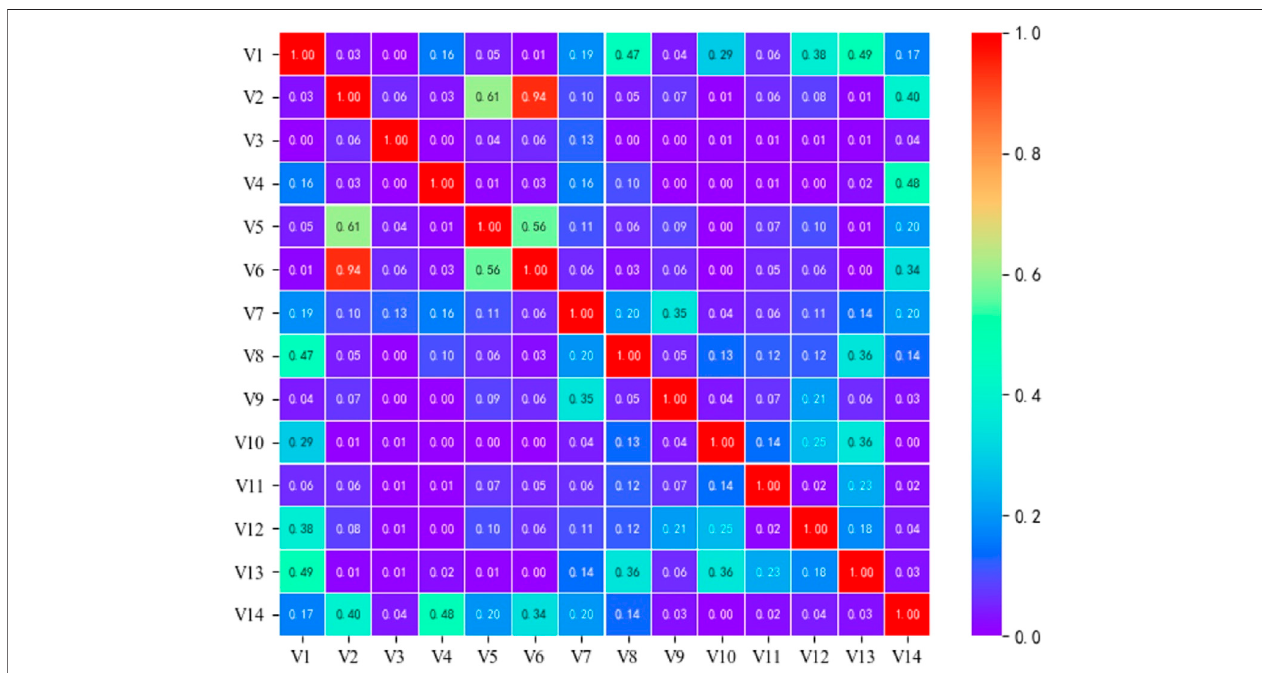
FIGURE 5 | Pearson correlation coef fi cient results. V1 Altitude; V2 Slope; V3 Aspect; V4 Curvature; V5 Topographic relief; V6 Surface roughness; V7 HI; V8 NDVI; V9 Average annual rainfall; V10 Lithology; V11 Distance to roads; V12 Distance to rivers; V13 Distance to villages; V14 TWI.